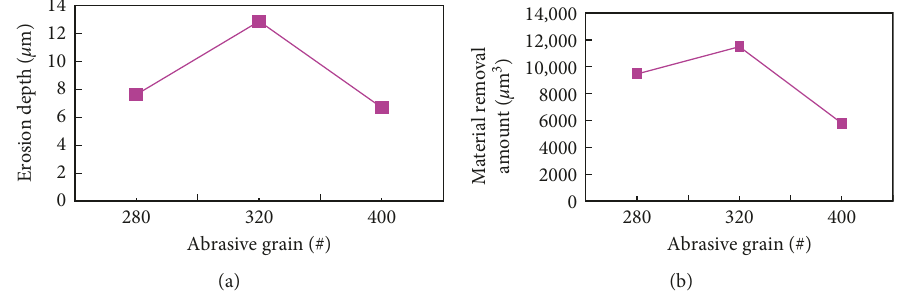
Figure 12: The influence of abrasive grain on (a) erosion depth and (b) material removal amount.